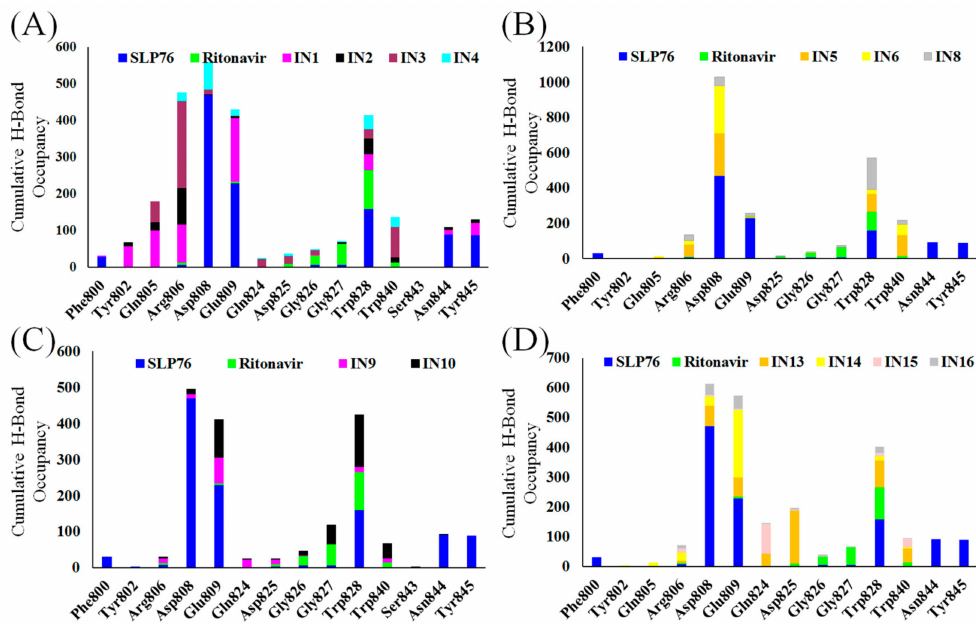
Figure 5. H-bond occupancy analysis for the PLC γ 1 residues in various systems over the last 10 ns in various complexes after MD simulations.